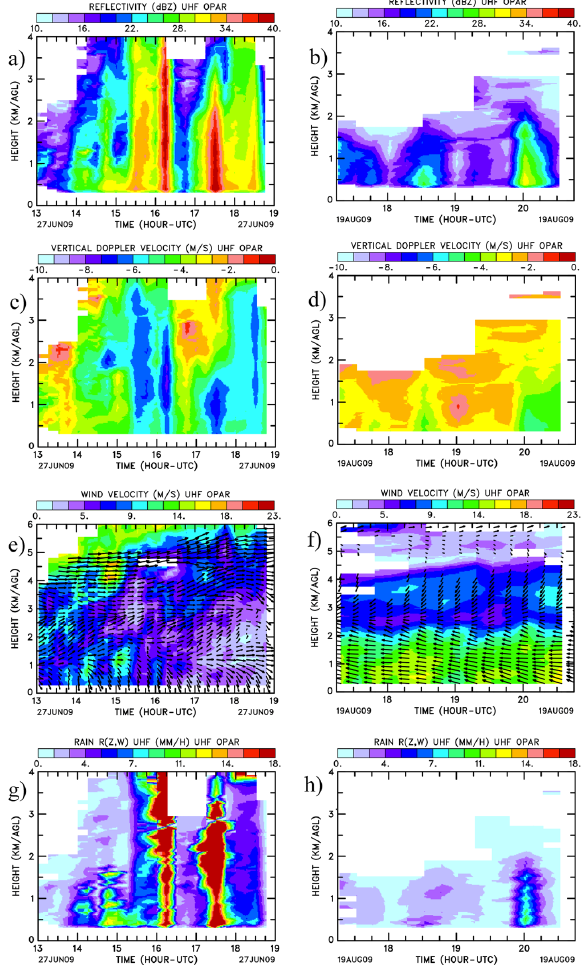
Fig. 7. Time–height sections of reflectivity factor Z (a, b) , vertical velocity W (c, d) , horizontal wind V intensity and direction (e, f) and precipitation rate R (g, h) on 27 June 2009 (left panel) and 19 August 2009 (right panel). A 15min average is used. Note that in (e – f) there are more data, since all the data was taken into account. The NNE case on the 17th march is characterized by less intense precipitation, but is associated with short pulses of very intense precipitation. Reflectivity, vertical Doppler velocity and horizontal wind measurements show significant